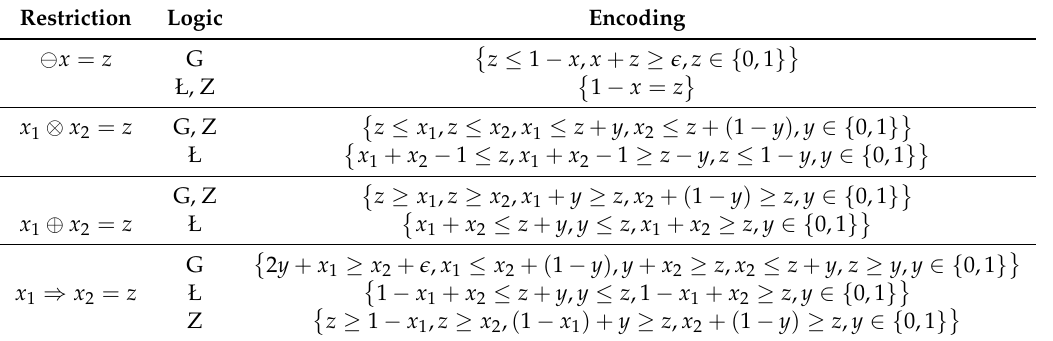
Table 4. Encoding of some popular fuzzy logic operators